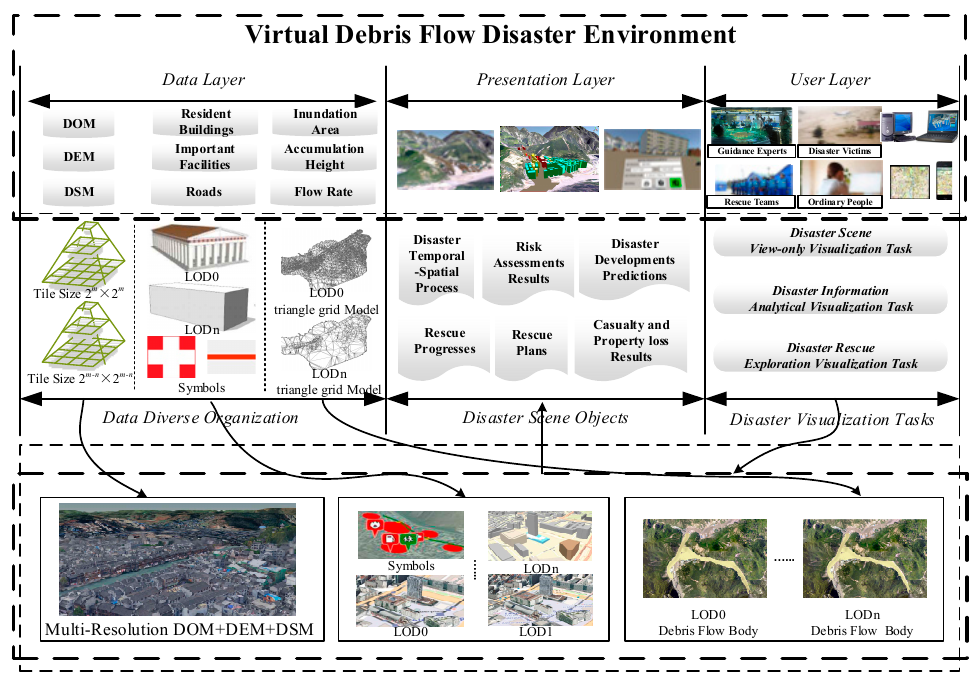
Figure 5. Diverse organization method of multitype debris flow disaster data